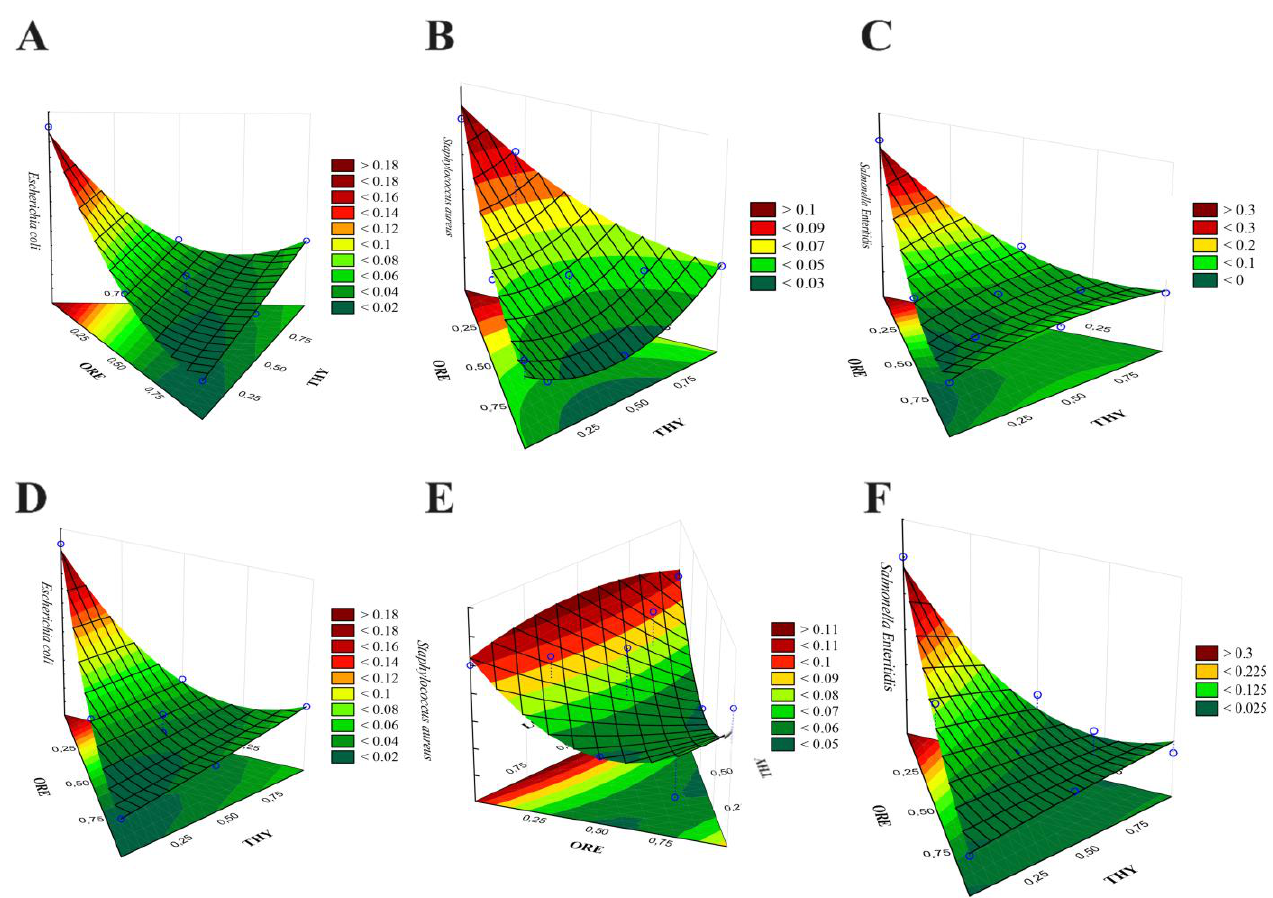
Figure 1. 3D surface plots for the effect of different essential oil blends from oregano (ORE; Origanum vulgare ), thyme (THY; Thymus vulgaris ), and lemongrass (LG; Cymbopogon citratus ) on minimum inhibitory concentration (MIC) value against Escherichia coli ( A ), Staphylococcus aureus ( B ) and Salmonella Enteritidis ( C ) and on minimum bactericidal concentration (MBC) value against Escherichia coli ( D ), Staphylococcus aureus ( E ) and Salmonella enterica serotype Enteritidis ( F ). Results are expressed in percentage (%) and are from twelve experiments, including three central replicates (Section 5.3).